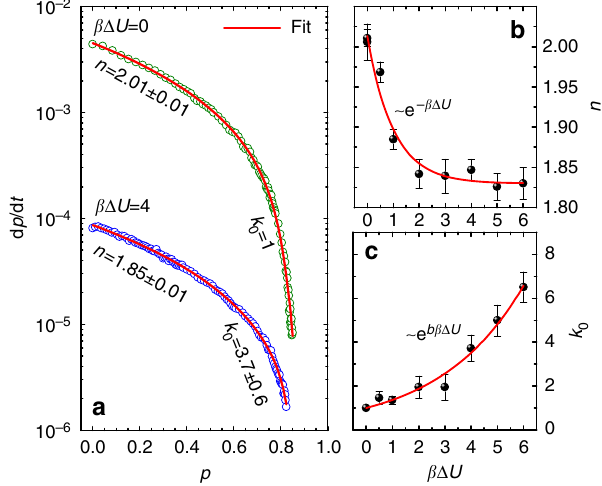
0.0 Fig. 5 Dependence of non-autocatalytic kinetics on the height of barrier. a Comparison between the kinetics of the model with barrier and without barrier. The data are fi tted by d p /d t = k overall (1 − p ) 2 , where k overall = (1/ k chem − 1 with k + 1/ k k diff ) chem and diff given by Eq. 2, by weighting each datapoint with its standard error (not shown since within the symbol size). By using k c = 4.56 ⋅ 10 − 3 and k = 1.015 obtained with β Δ U = 0, and D ( p ) obtained from d the mean-squared displacement, the fi t only adjusts two parameters, n and k 0 , for each β Δ U >0. The uncertainty of the best- fi t parameters is reported in b and c with error bars. b The barrier dependence of the exponent n is analytically described by n = ( n 0 − n ∞ )e − β Δ U + n ∞ , with n 0 = 2.01±0.01 and n ∞ = 1.830±0.006. c The barrier dependence of k 0 , over the investigated range, is approximated by k 0 = e b β Δ U , with b =